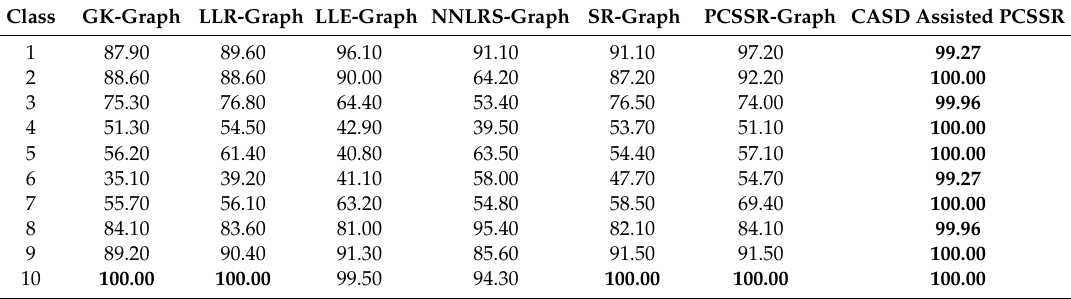
Table 4. Classification accuracy of each class, OA, AA and Kappa coe ffi cients for KSC data with 13 classes (20 training samples for each class). The highest value of each row is shown in